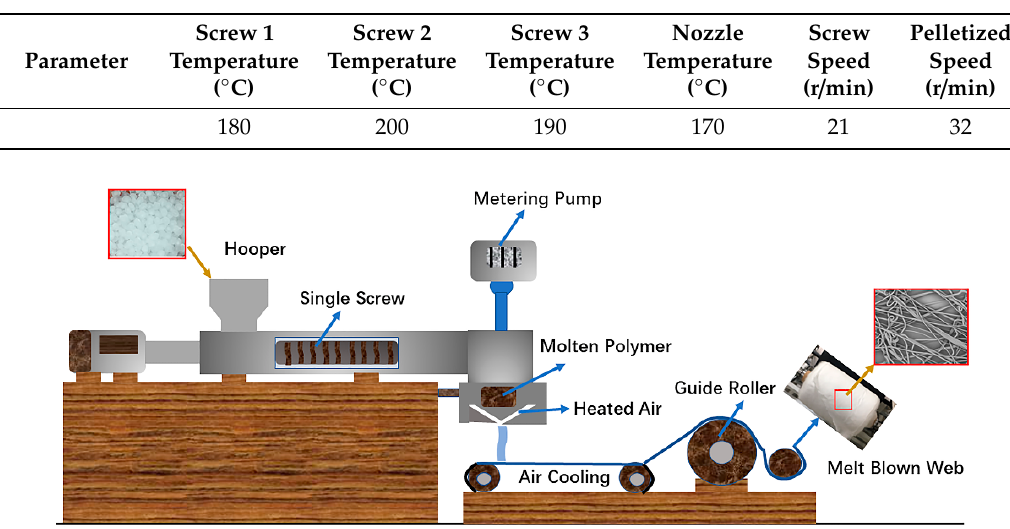
Table 1. The Processing parameters of melt-blending.